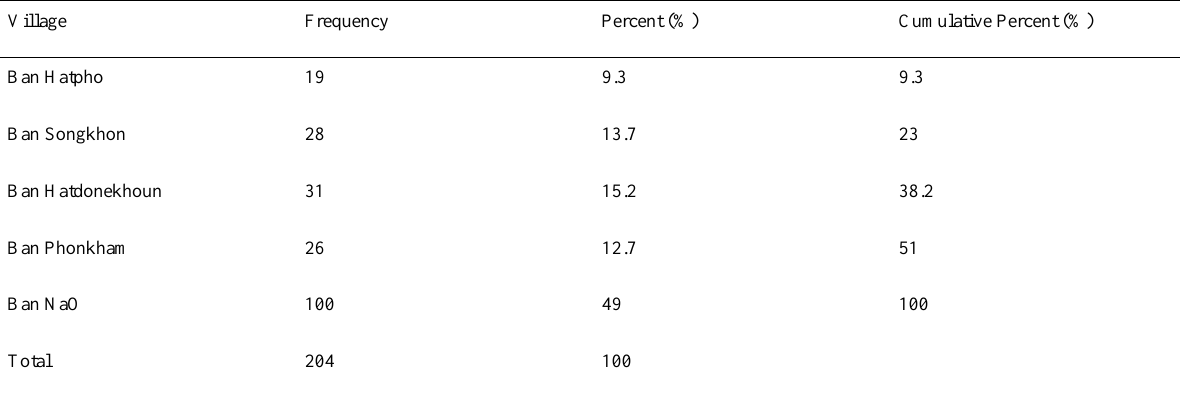
Table 1. Distribution of Study Sample across Units of Analysisi ( N